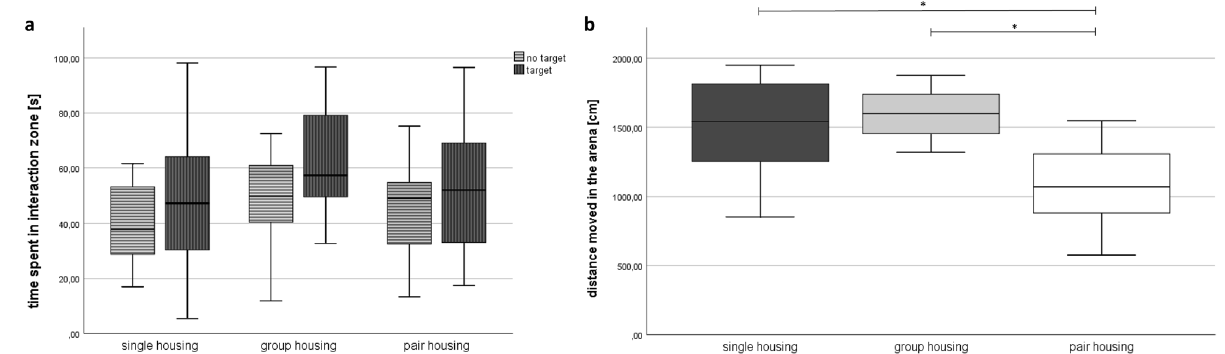
Figure 8. Social interaction test. ( a ) Time spent in interaction zone and ( b ) distance moved in the entire arena in absence of the target mouse in week 7. Data are presented as boxplot diagrams: the box represents the interquartile range (IQR), box edges are the 25th and 75th quartile. Single housing: n = 16, group housing: n = 16, pair housing: n = 16. * p < 0.05 versus the other housing